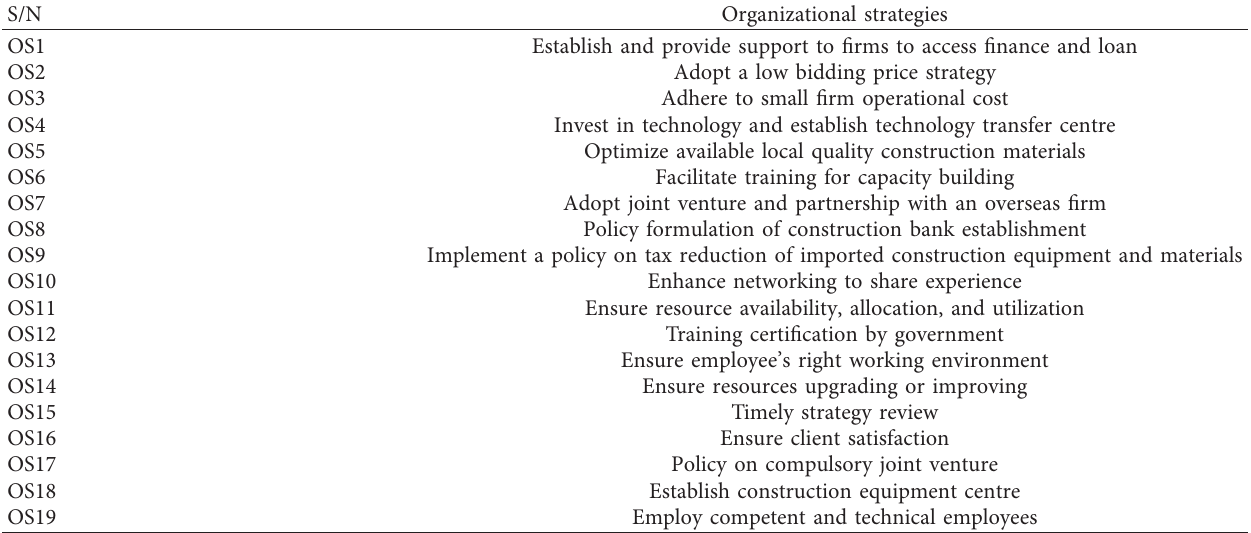
Table 4: Selected organizational strategies (OSs) considered in the current study.